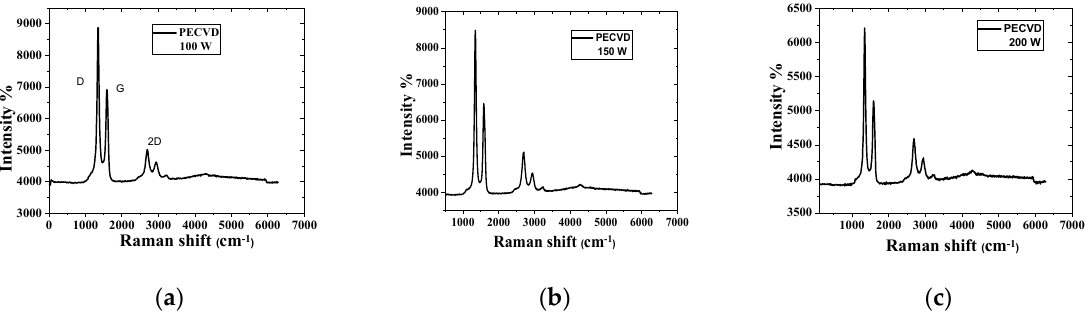
Figure 4. Raman analyses of Gr nanowalls synthesized using the PECVD technique at ( a ) 100 W, ( b ) 150 W, ( c ) 200 W.